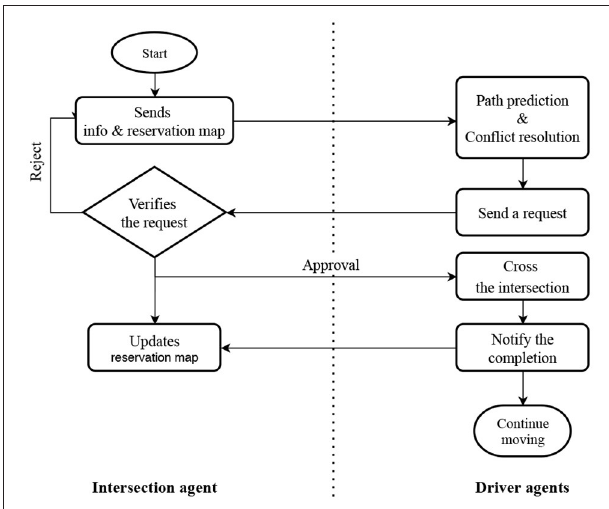
FIGURE 5 | The interactions flow between the IMA and